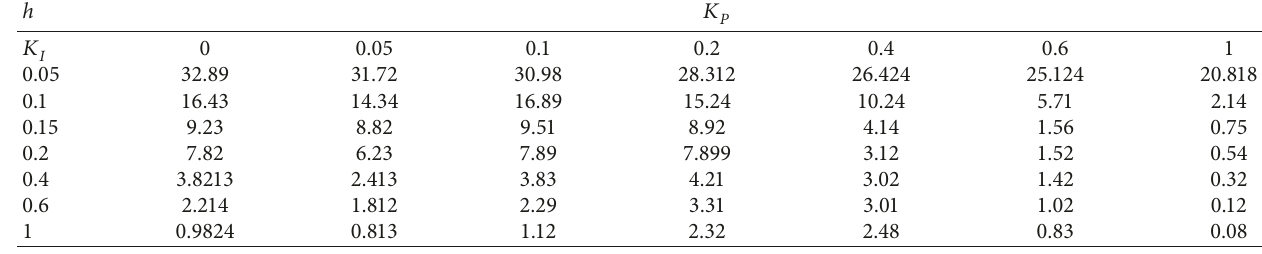
, K ) for single-area LFC with μ � 0 , ρ � 0 , τ � 0. P I